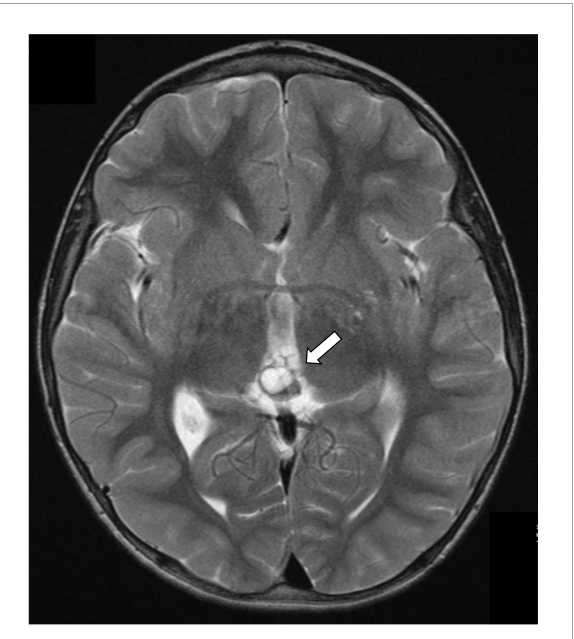
FIGURE1 Gadolinium-enhanced brain magnetic resonance highlighting a 5 mm bilobed cyst of the pineal gland